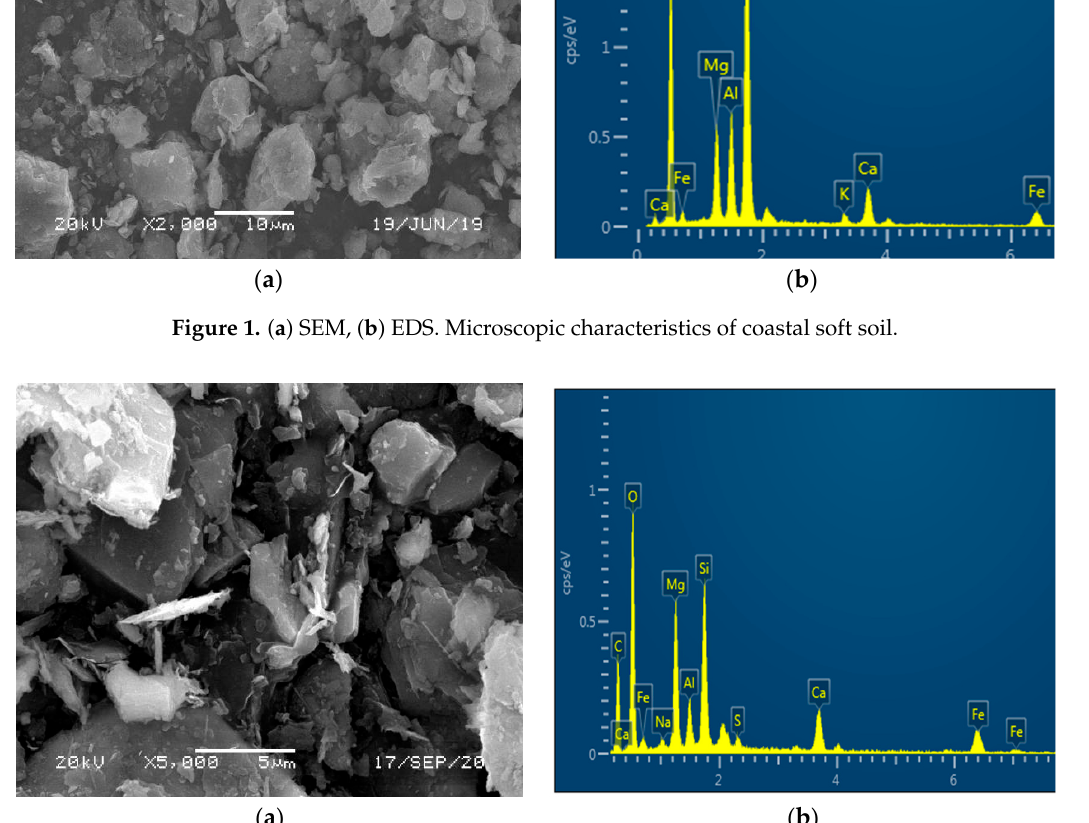
Figure 2. ( a ) SEM, ( b ) EDS. Microscopic characteristics of iron tailings.